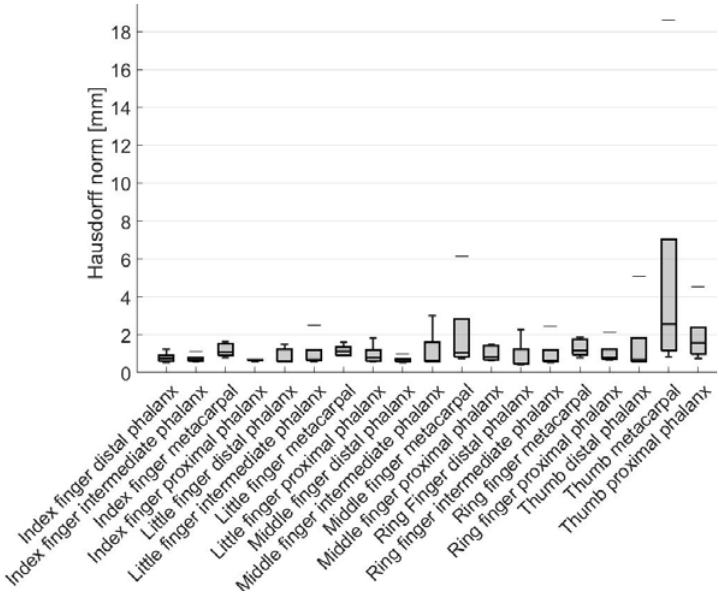
Figure 3. Statistics of Hausdorff distance [mm] for each finger bone summarized for all five reference configurations.